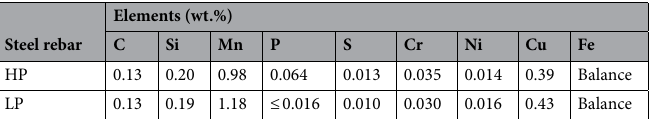
Table 1. Chemical analysis results for steel rebars obtained using optical emission spectrometer.